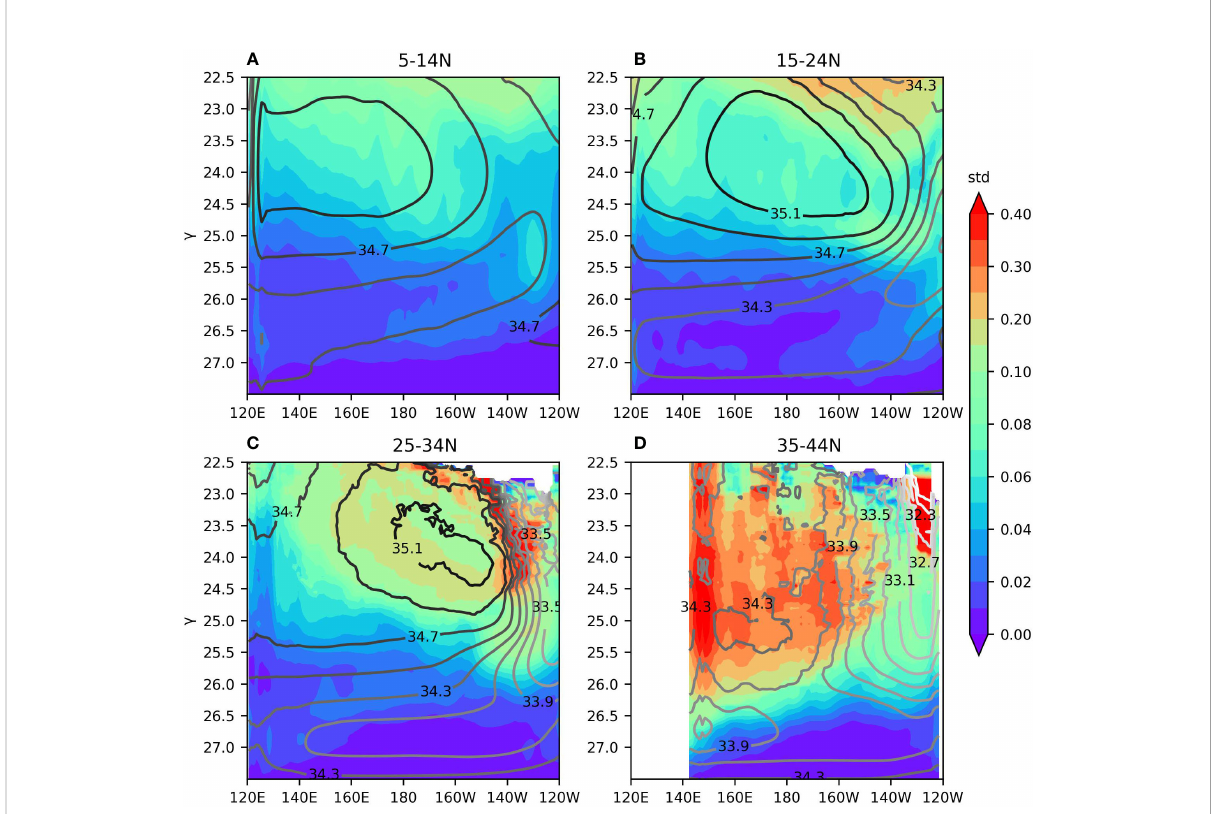
FIGURE 2 Climatology (contour) and standard deviation (color) of the salinity during 2004 – 2018 with respect to neutral density (unit = kg·m − 3 ), which were averaged in (A) 5 – 14°N, (B) 15 – 24°N, (C) 25 – 34°N, and (D) 35 – 44°N. Contour interval is 0.2. The grids in the Sea of Japan are whitened in (D)